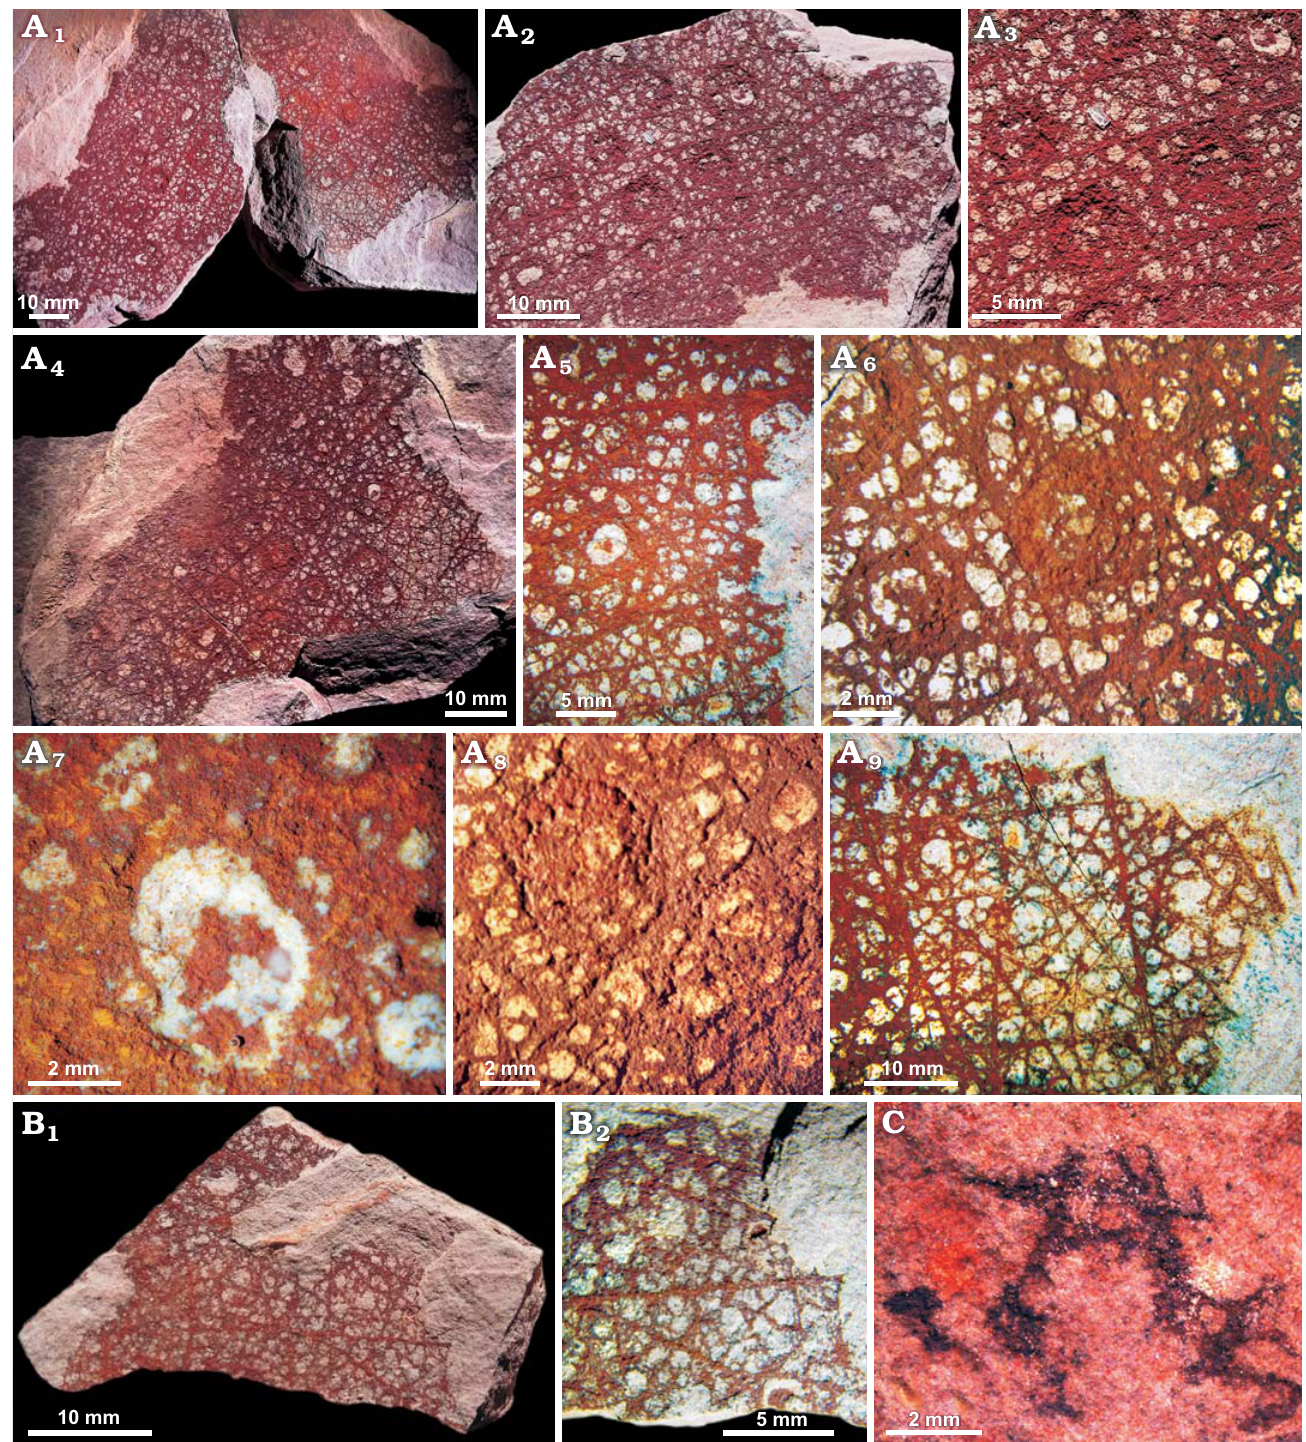
Fig. 5. Reticulosan sponge Valospongia sonorensis sp. nov. from the middle Cambrian El Mogallón Formation at Cerro El Mogallón, Sonora, Mexico. A . Holotype IANIGLA-PI 3094a/b, overall view of part and counterpart of specimen. A 1 , view of inner layer of the holotype; A 2 , detail showing base of mounds and largest spicules in semi-quadruled array; A 3 , view of outer layer; A 4 , part of the skeleton, showing semi-regular outer spicules, mounds and parietal gaps of inner layer; A 5 , detail of mound covered in parts by reticulate mesh, visible in places; A 6 , close-up of round recrystallised mound; A 7 , detail of a mound base with dermalia visible in places, and parietal gaps of inner layer; A 8 , view of part of parenchymal/choanosomal skeleton with largest spicules and smaller spicules distributed at parietal gap margins; A 9 , bundles composed of the largest distinct spicules, with coarse, straight and simple rays. B . Paratype IANIGLA-PI 3095; B 1 , overall view of the fragment; B 2 , detail showing largest spicules of primary reticulation and smaller spicules at parietal gap margins. C . IANIGLA-PI 3119, fragment of V. sonorensis with spiculation of the outer wall obscured by pyritisation at the margin of subcircular parietal